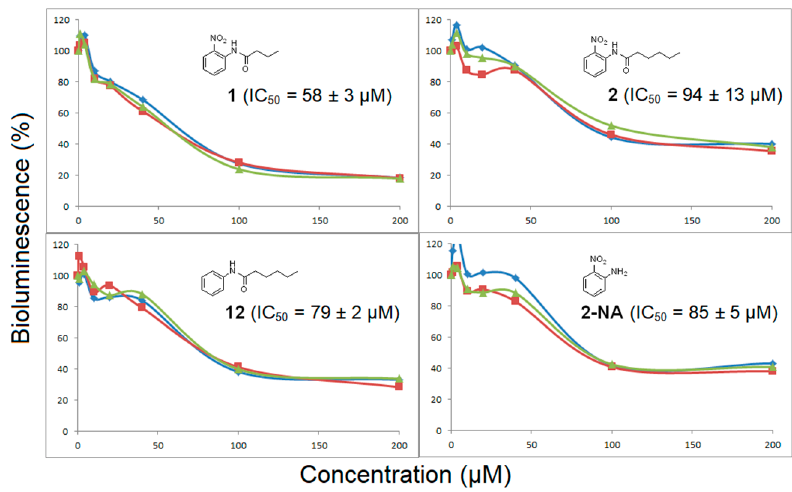
Figure 5. Antagonistic activity of 2-NA, and acyl 2-nitroaniline derivatives 1 – 2 and acyl aniline 12 . Other derivatives were inactive (not shown). Bioluminescence was induced with 200 nM of 3-oxo-C6-HSL. The experiments were carried out in triplicate shown in different colors.